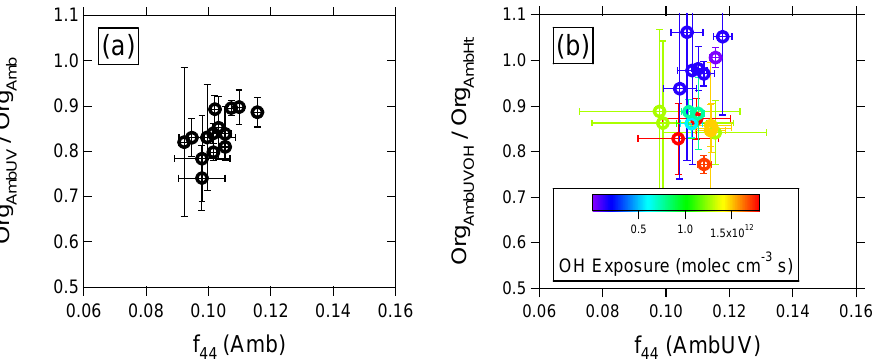
Fig. 3. (a) Fraction of organic mass remaining at the AmbUV condition as a function of f 44 . Volatilization occurs as a result of a 4 ◦ C increase in temperature. (b) Organic mass decrease as a function of f 44 and OH exposure. Note that axes do not go to zero in either